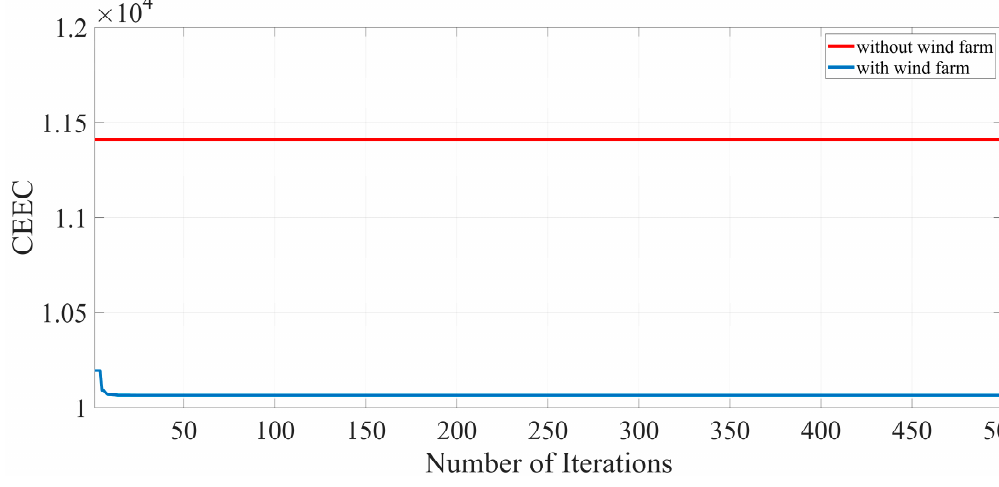
Figure 11. The convergence curves for CEEC minimization for the Test System 2.